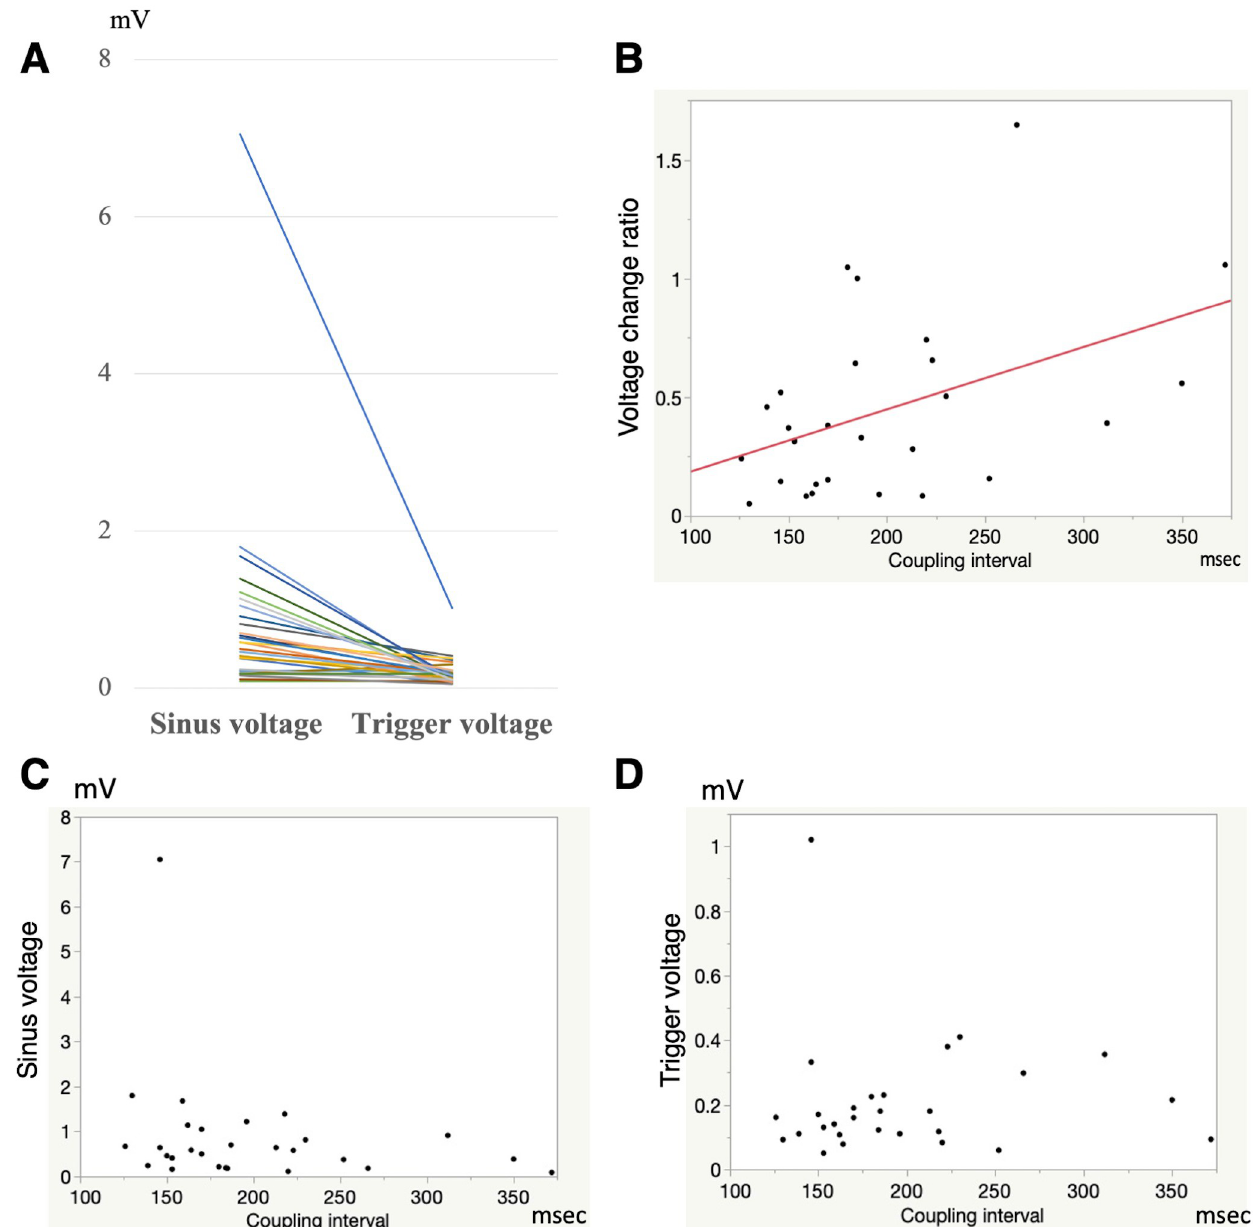
Fig 3. Left panel: Voltage change from the sinus beat to the onset of AF. The trigger voltage at the onset of AF was significantly more reduced than the sinus voltage (0.16 mV vs. 0.58mV, p = 0.005). Right panel: The relationship between the voltage change ratio and trigger coupling interval. The voltage change ratio was significantly correlated to the trigger coupling interval (R = 0.44, β = 0.44, p = 0.0189). change ratio was significantly lower in the normal sinus voltage group than low sinus voltage group (0.20 vs. 0.60, p = 0.002).